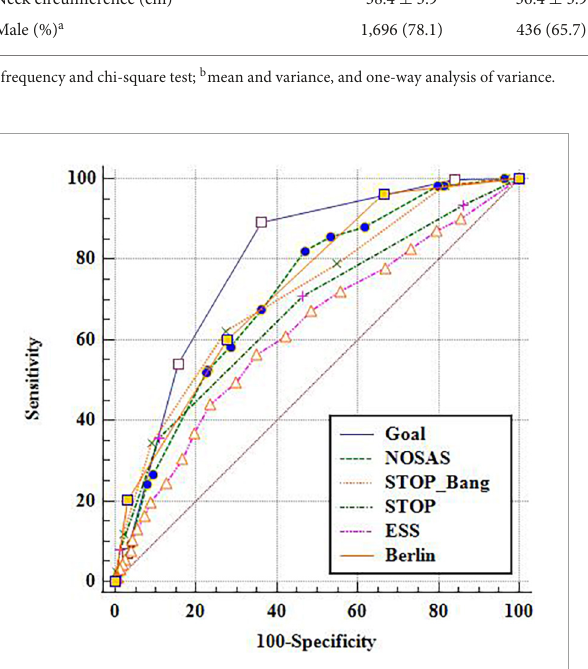
FIGURE1 ROC curve with apnea hypopnea index (AHI) 5 as cut-off point.